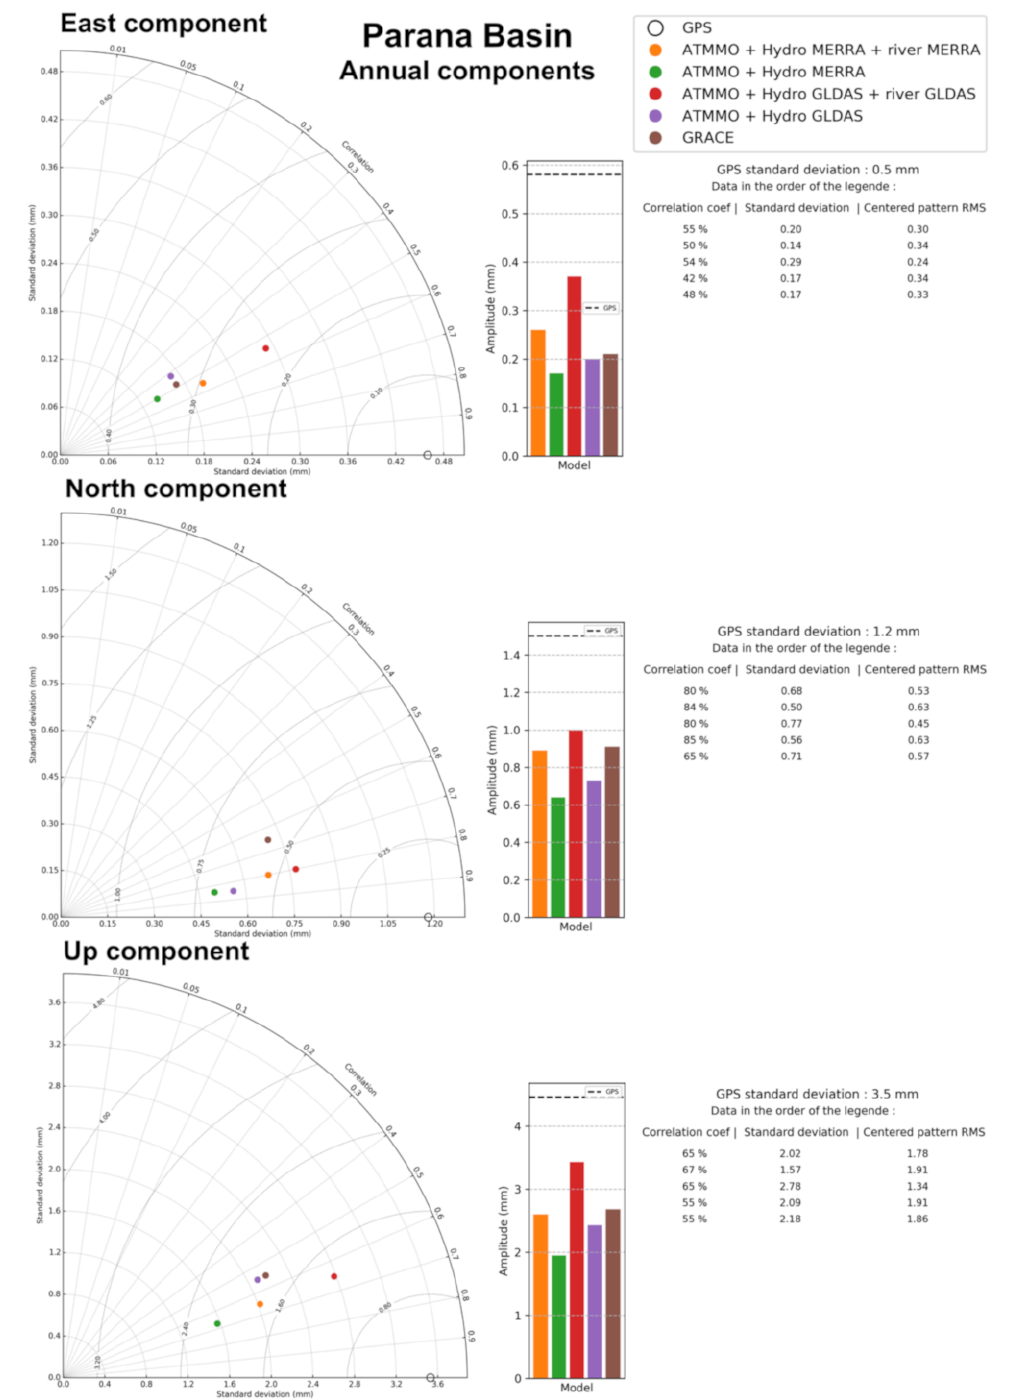
Figure 11. Taylor diagram for the annual term for Parana